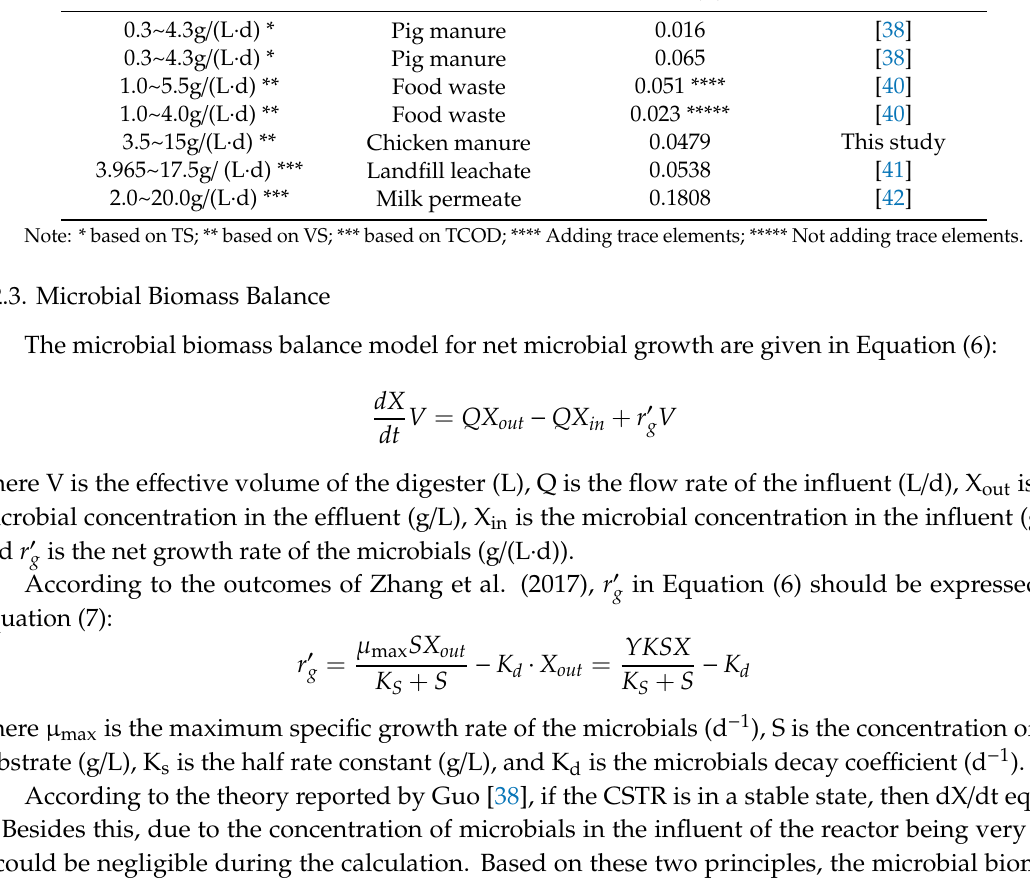
Microbial Biomass Yield